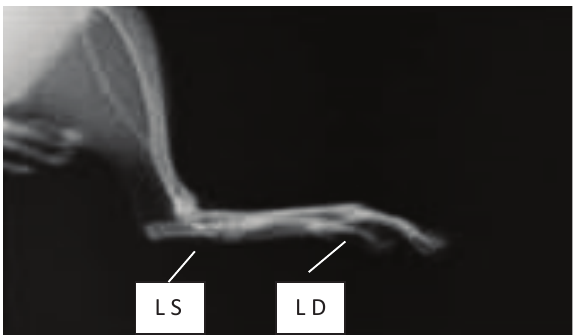
Fig-9: Therapeutic Group 9 Anthraquinone 250mg/kg treated rats showing reduced progression of RA with low joint swelling and less narrowing of joint space.